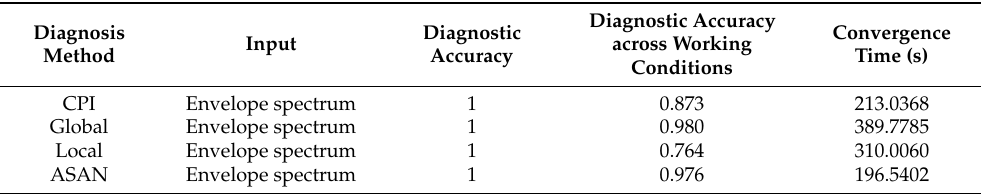
Table 7. Diagnostic performance of different methods.